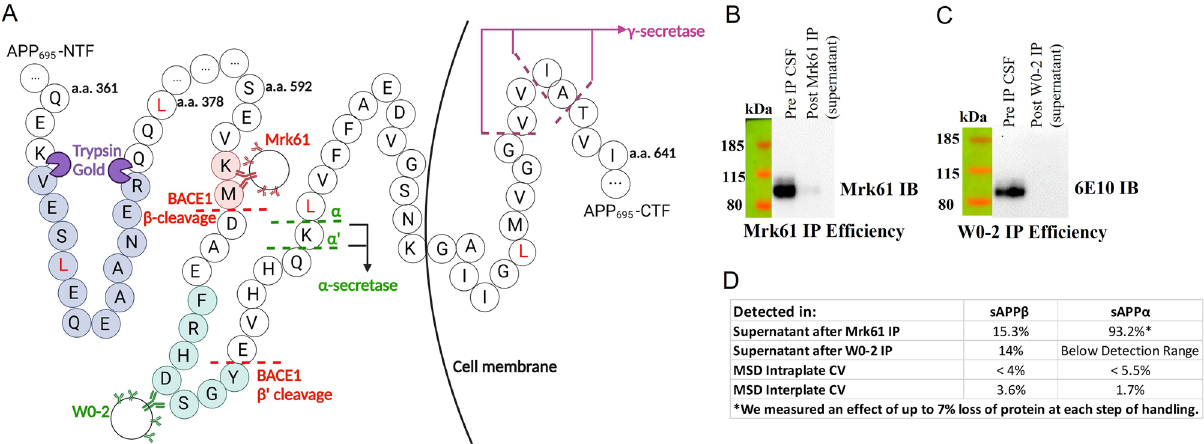
Figure 2. Partial APP 695 isoform sequence and antibody efficiency. ( A ) Red dashed line indicates BACE1 cleavage sites (β-site is the predominant cleavage location, with the β’ site being a significantly lesser contributor). Green dashed lines show the α-secretase cleavage sites (α’ is a significantly lesser contributor). Fuchsia arrows show γ-secretase cleavage sites, that, if preceded by BACE1 cleavage at the β cleavage site, would result in Aβ 38 , Aβ 40 , or Aβ 42 , respectively. Mrk61 antibody bound to Sepharose beads recognizes the neo-epitope of sAPPβ (-KM highlighted in red), whereas W0-2 antibody bound to Sepharose beads recognizes a short sequence C-terminal to the β-secretase cleavage location, which is only located in sAPPα or Aβ (green highlight), but not in sAPPβ. The APP mid-domain tryptic peptide quantified by MS is shown in blue highlight. It is a peptide common to both sAPPβ and sAPPα. Leucines that may incorporate label are shown in red. Panel created with BioRender.com. ( B ) Efficiency of Mrk61 immunoprecipitation showing sAPPβ in the starting material and in the supernatant of the sample after IP. Original full blot is presented in Supplementary Fig. S5A. ( C ) Efficiency of W0-2 immunoprecipitation showing sAPPα in the starting material and in the supernatant of the sample after IP. Original full blot is presented in Supplementary Fig. S5B. ( D ) Percentages of sAPPβ and sAPPα (from starting material) remaining in supernatants of the serial immunoprecipitation as measured